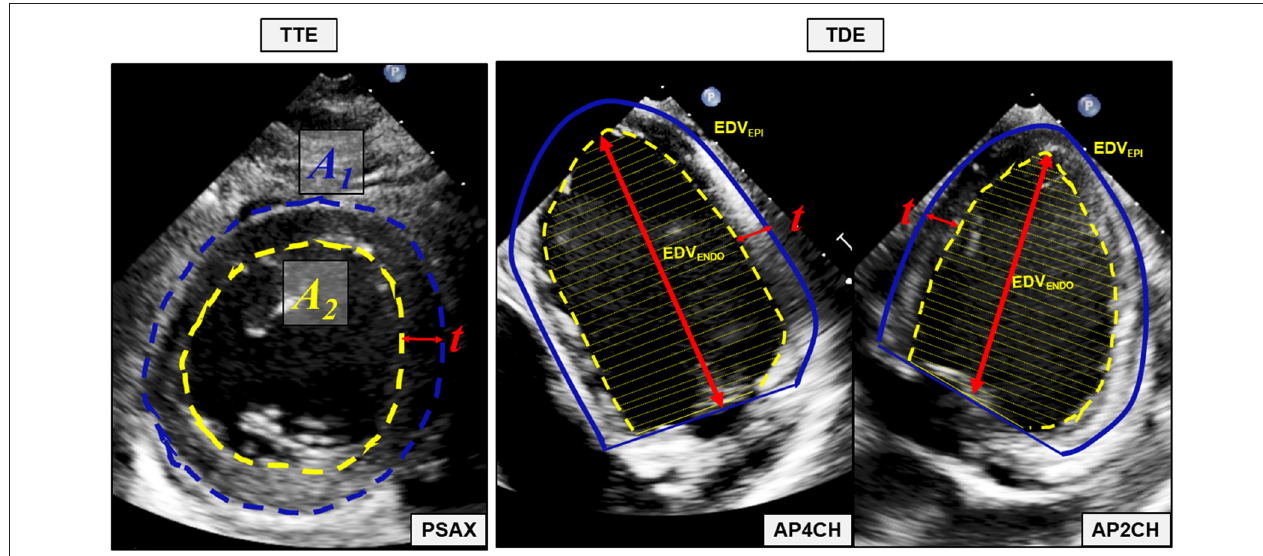
FIGURE 2 | The novel 2D-based echocardiographic method for quantification of left ventricular mass. Mean wall thickness ( t ) is calculated by tracing of the endocardium (A 2 ) and the epicardium (A 1 ) in the parasternal short axis (PSAX) view. The left ventricular volume defined by the endocardium (EDV ENDO ) is acquired using the biplane methods of disks with tracings of the endocardium in the apical four chamber (AP4CH) and apical two-chamber (AP2CH) view. Mean wall thickness ( t ) is added to each unique disk and a new volume, the left ventricular volume defined by the defined by the epicardium (EDV EPI ) is quantified. Myocardial volume is calculated by subtracting EDV ENDO from EDV EPI and left ventricular mass is quantified by multiplying the myocardial volume with the myocardial density/gravity of 1.05 g/ml. TTE transthoracic echocardiography, TDE , transdiaphragmatic echocardiography; PSAX , parasternal short axis view; A 1 , Area defined by the epicardium; A 2 , Area defined by the endocardium; t , mean wall thickness; AP4CH , apical four chamber view; EDV ENDO , the left ventricular volume defined by the endocardium; EDV EPI , the left ventricular volume defined by the epicardium; AP2CH , apical two-chamber view.